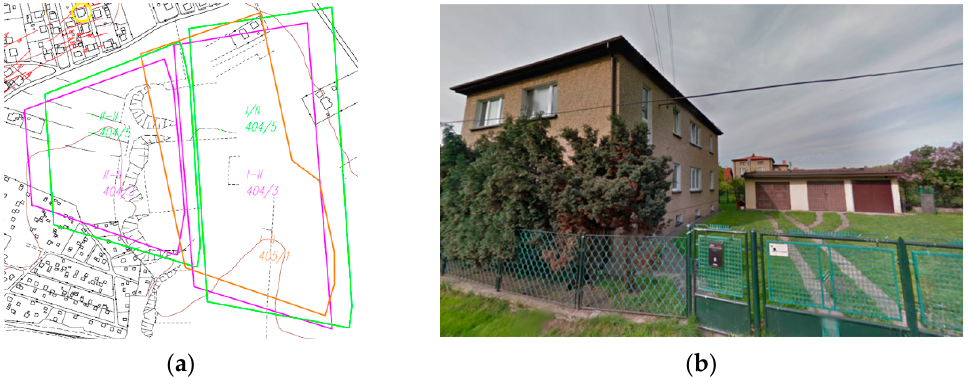
Figure 2. A residential building: ( a ) on the background of the longwall’s contours in the 404/3 seam—pink line, the 404/5 seam—green line and the 405/1 seam—orange line (yellow circle); ( b ) a view from north-eastern side.